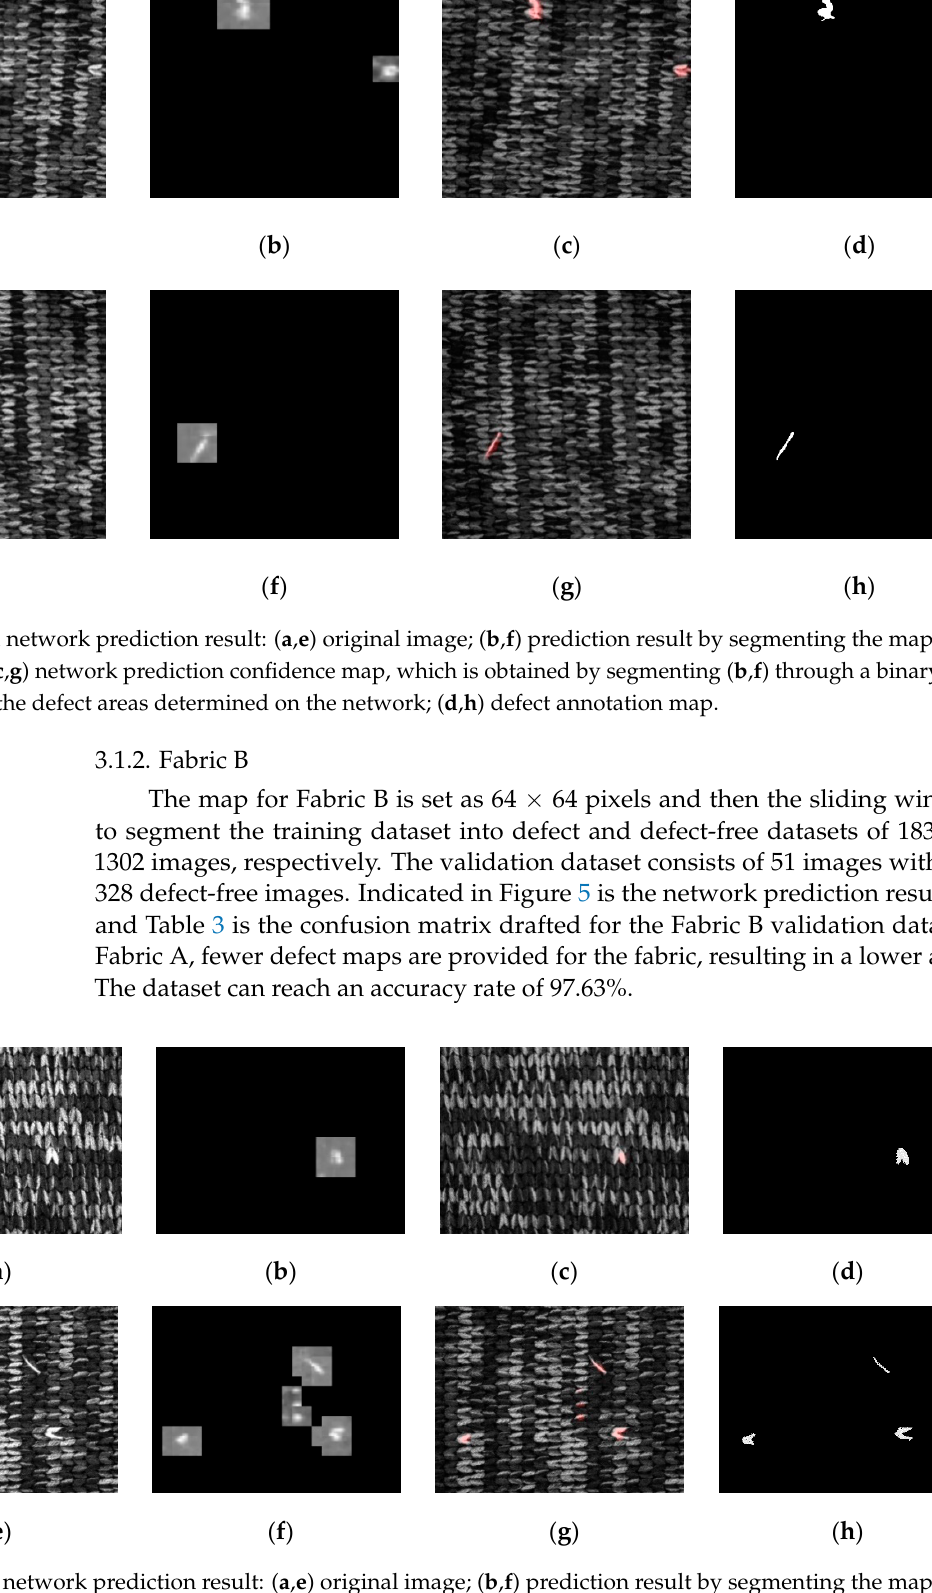
Figure 5. Fabric B network prediction result: ( a , e ) original image; ( b , f ) prediction result by segmenting the map with the sliding window; ( c , g ) network prediction confidence map, which is obtained by segmenting Figure ( b , f ) through a binary process; the red pixels are the defect areas determined on the network; ( d , h ) defect annotation